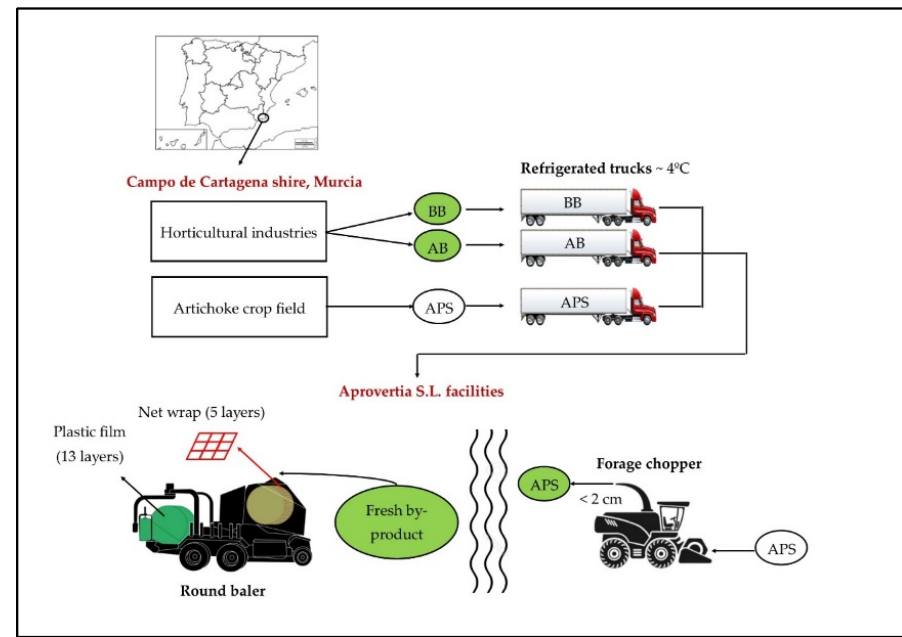
Figure 1. Ensiling process of the three by-products studied.